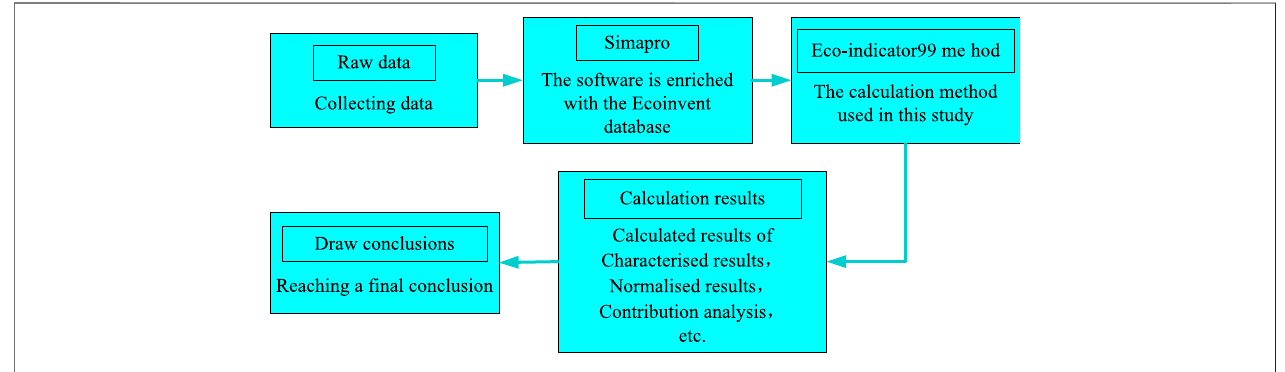
FIGURE 1 | Life cycle assessment fl ow